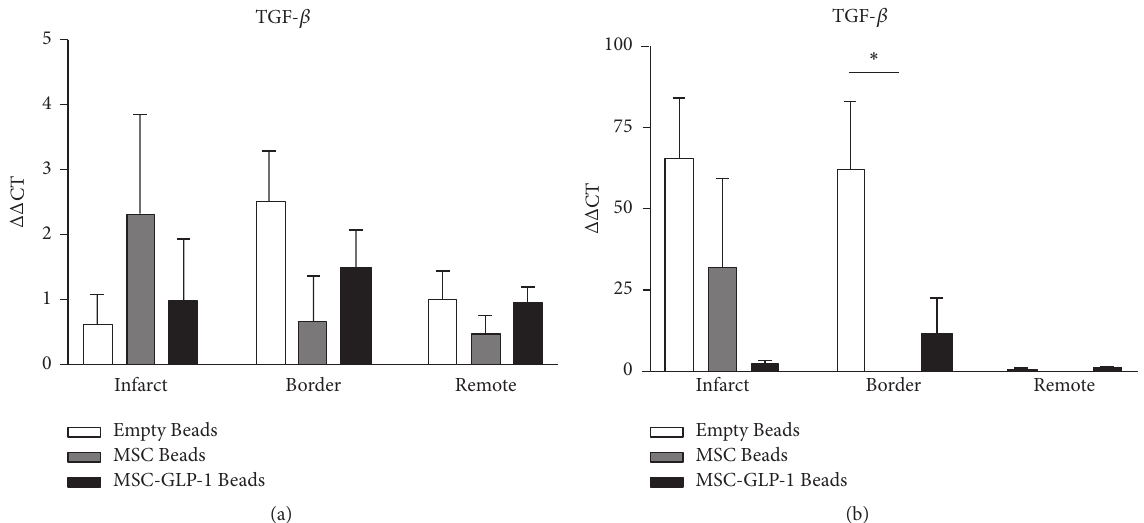
Figure 5: Quantification of TGF- 𝛽 mRNA levels using qRT-PCR. (a) One week after MI, all groups exhibited minor increases in mRNA levels across all regions. (b) Four weeks after infarction, large increases in TGF- 𝛽 were found in the infarct of Beads and Beads-MSC groups. A significant increase was observed in the Empty Bead group in the border zone. 𝑁 = 3 – 5 per group; 𝑃 < 0.05